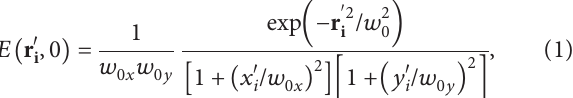
Figure 2: Normalized intensity distribution at the source plane along the horizontal direction of Lorentz–Gauss, Lorentz, and � w � 2mm and w � Gaussian beam for w 0 x 0 y 0